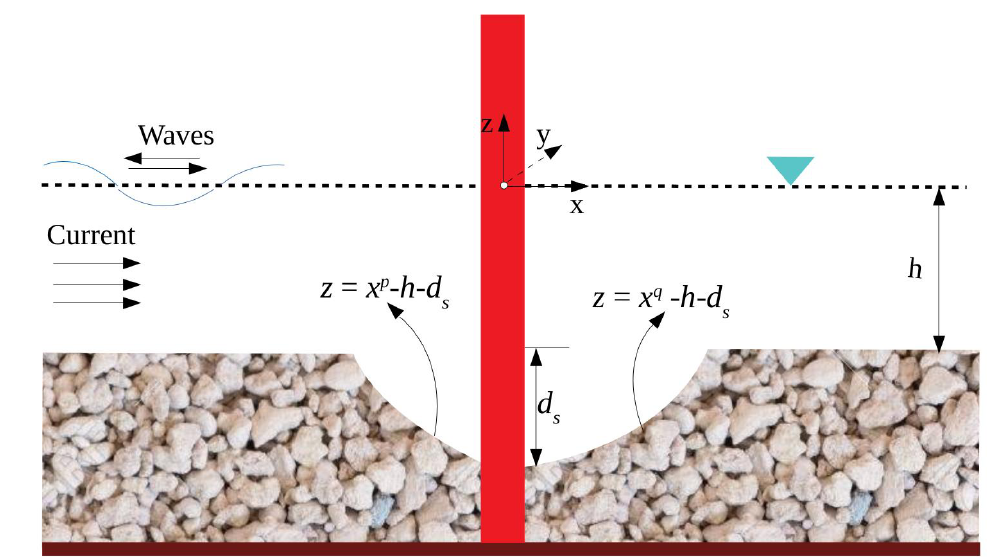
Figure 1. Schematic view of the formation of the equilibrium scour depth ( d s ) around a pier due to the collinear waves and